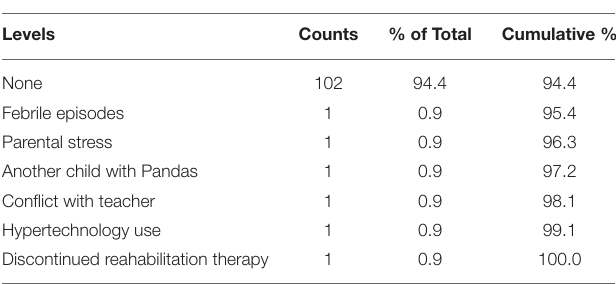
TABLE 9 | Q22 other negative factors.